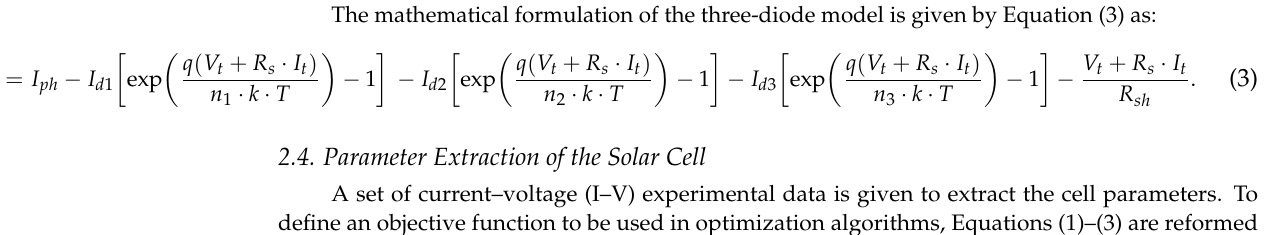
Figure 3. Three-diode model.